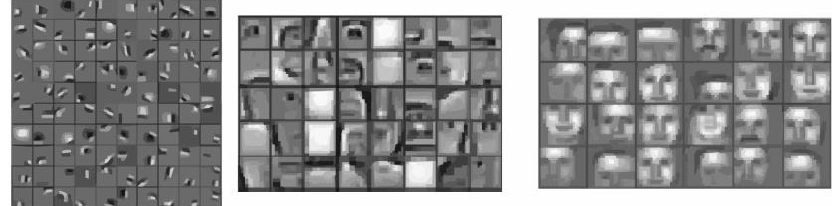
Figure 19. Unsupervised learning – Information extraction (Adapted from [28]). Figure 20. Unsupervised learning–Information extraction (Adapted from [28]).